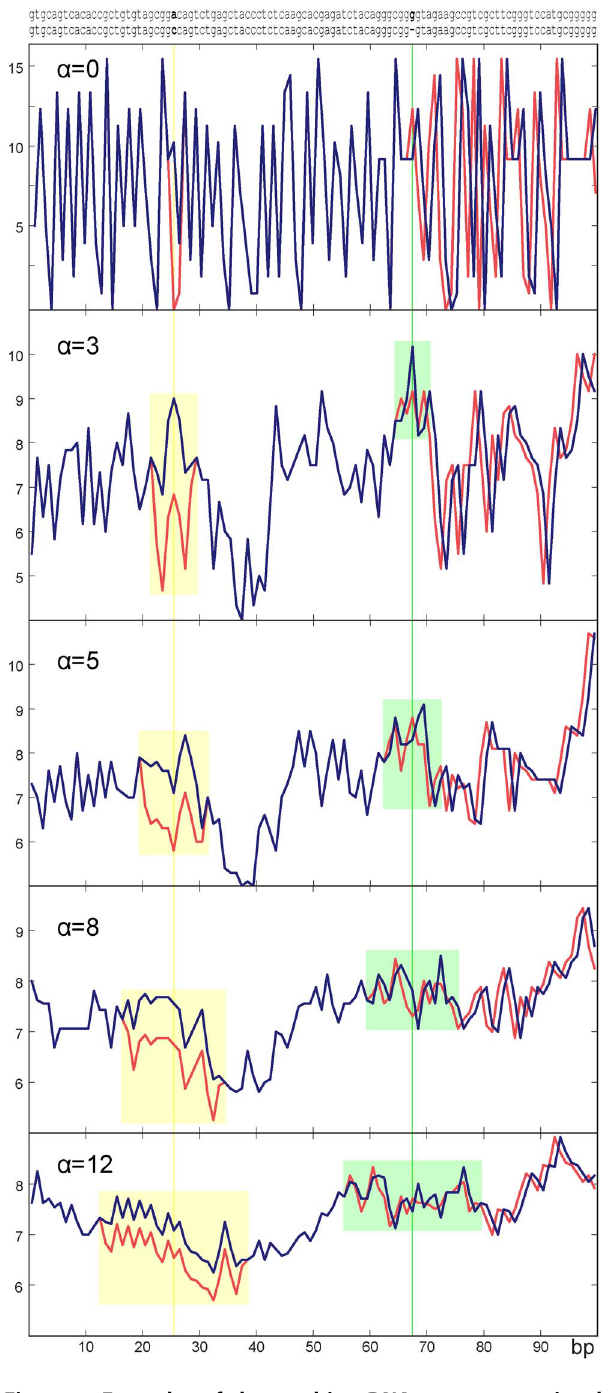
Figure 1. Examples of the resulting DNA sequence-to-signal tool employing different values of a and its effects on single sequence changes.